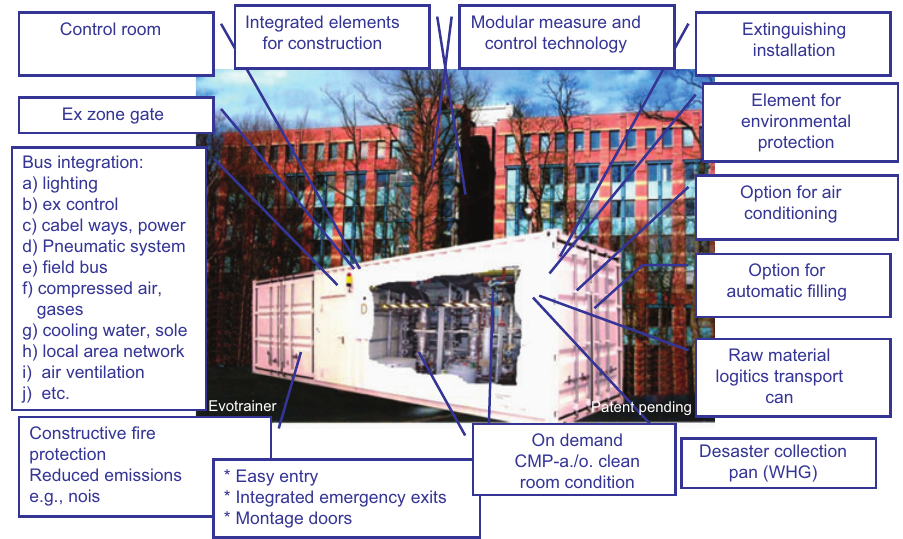
Figure 2 Evotrainer – Compact and pre-manufactured plant